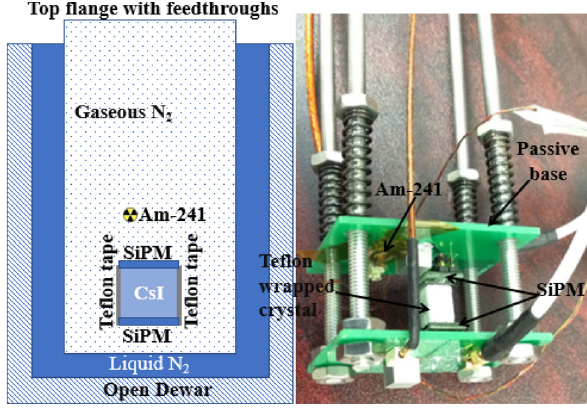
Fig. 1 A sketch and a picture of the experimental setup (sensor size: 6 × 6 mm 2 , pixel size: 35 × 35 µ m, total num- ber of pixels: 18980) SiPMs from SensL [49] were used.